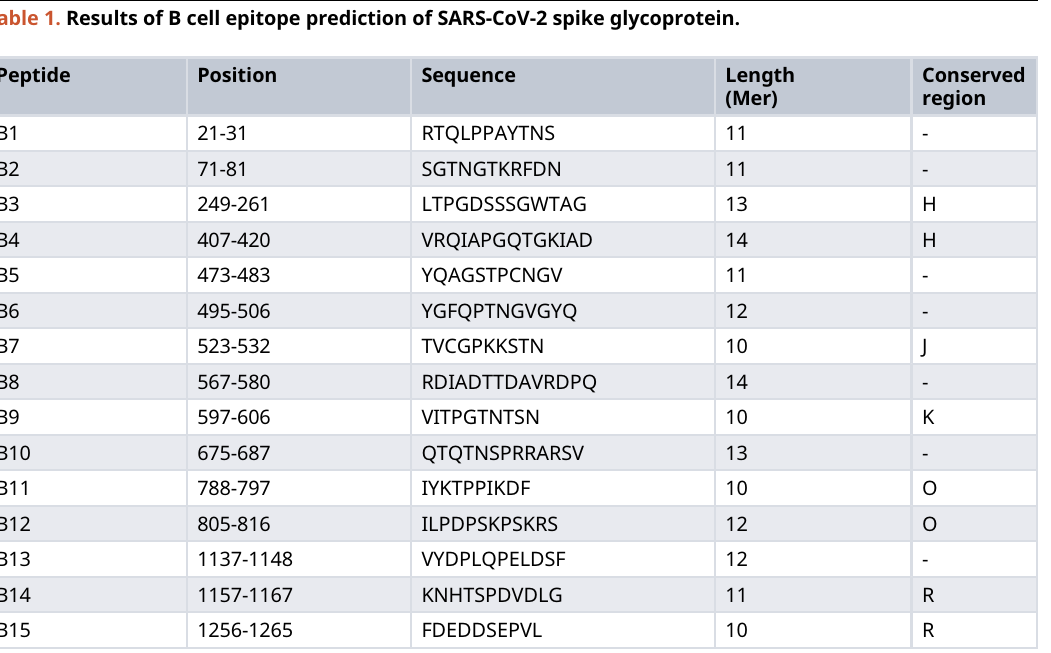
Table 1. Results of B cell epitope prediction of SARS-CoV-2 spike